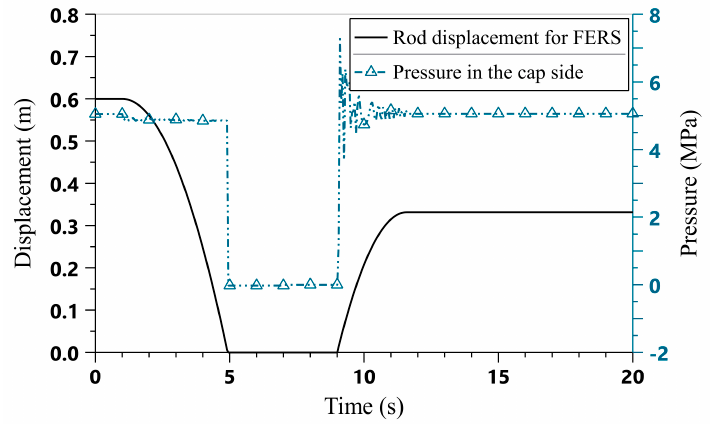
Figure 13. The boom cylinder displacement and the pressures of the boom cylinder of FERS.